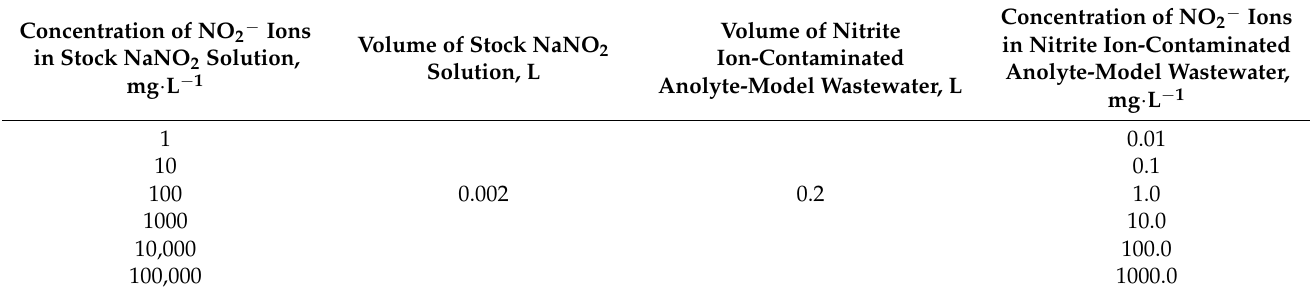
Table 1. Data for preparation of nitrite ion-contaminated anolyte–model